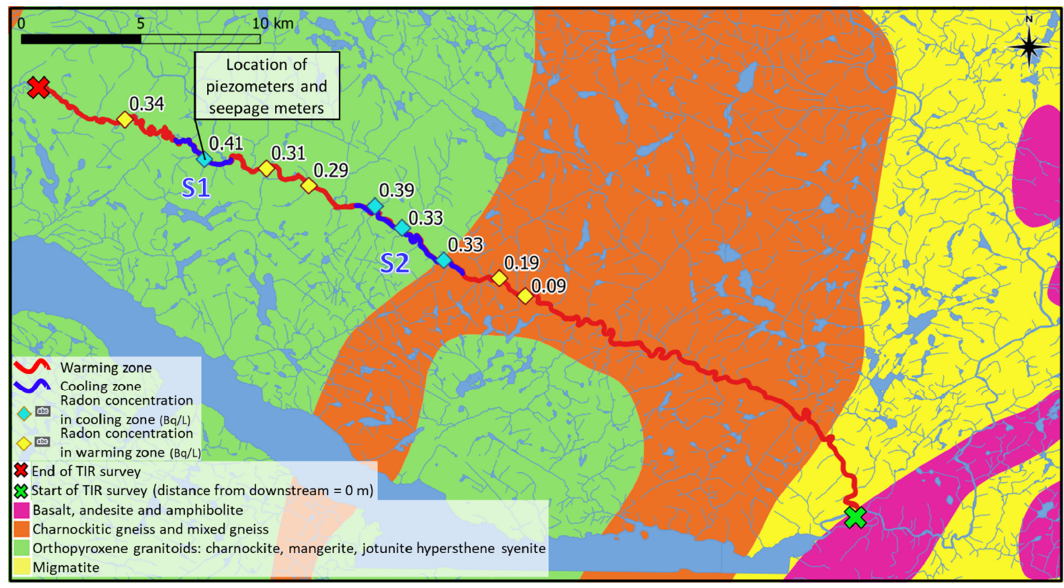
Figure 7. Cooling zones and radon sampling points of Saint-Marguerite River.